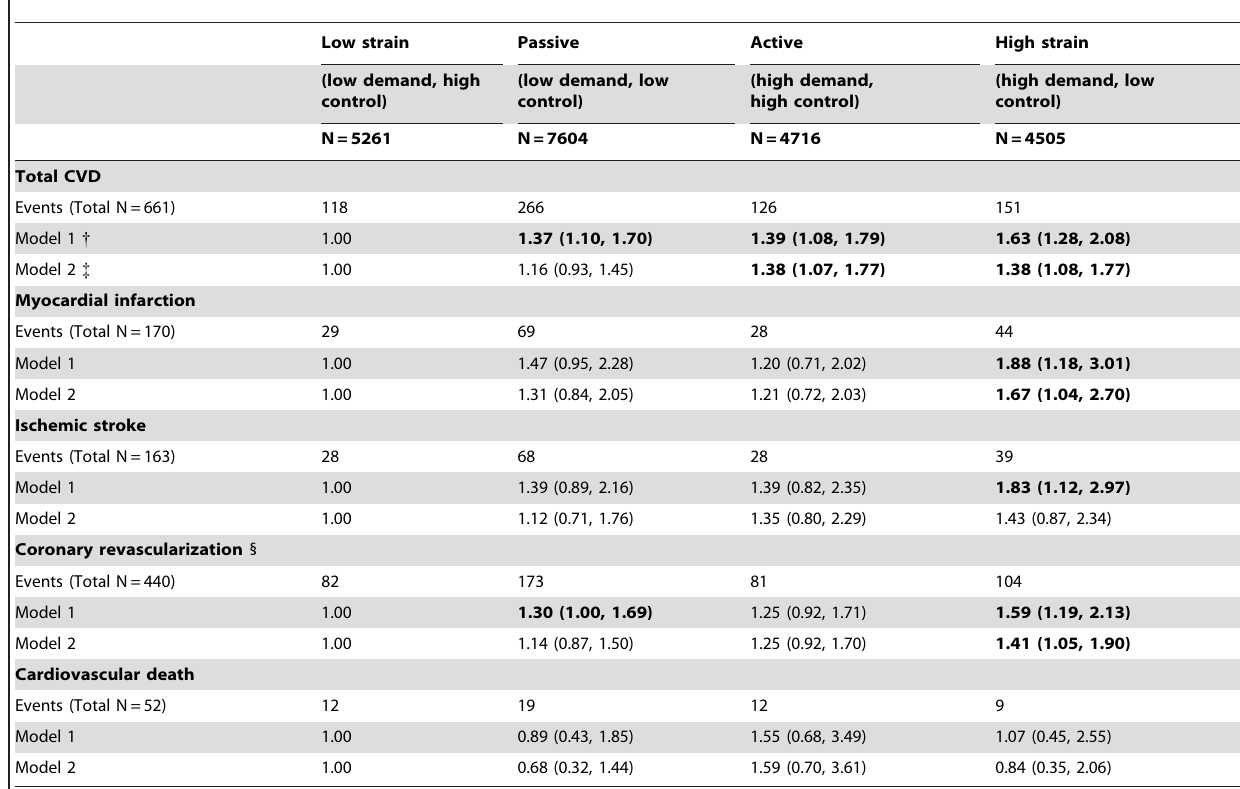
Table 2. Hazard rate (HR) and 95% confidence interval of cardiovascular disease by job strain